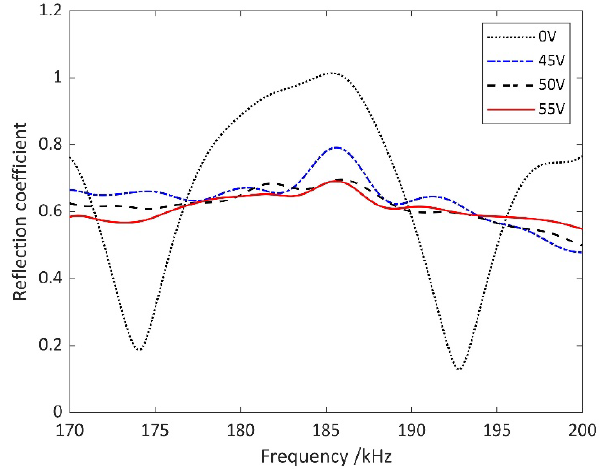
Figure 12. The reflected signal spectrum under different electrolytic currents measured experimentally.